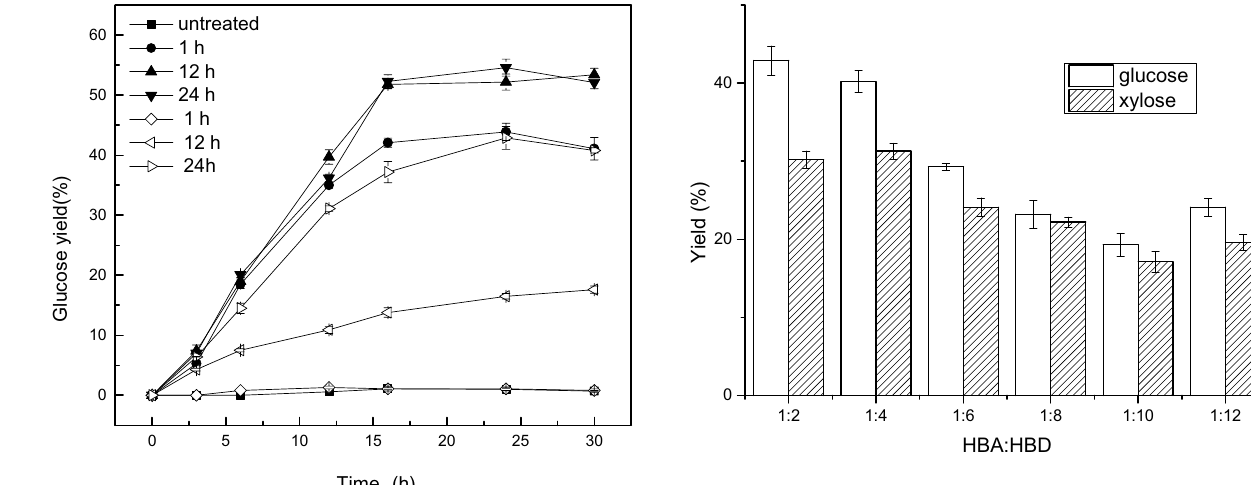
Fig. 6 Glucose and xylose yield from solid acid catalysed hydroly- sis of corn stover pretreated by ChCl·formic acid with different HBA:HBD ratio. (Hollow column: Glucose yield from pretreated MCC, Shadow column: xylose yield from pretreated corn stover).